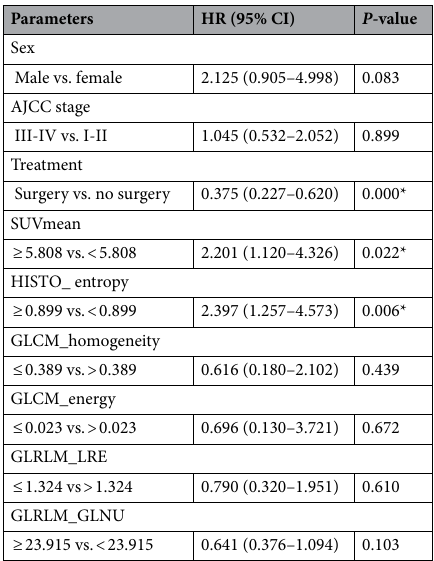
Table 6. Multivariate Cox regression analysis of OS. HR hazard ratio, CI confidence interval, AJCC American joint committee of cancer, SCC squamous cell carcinoma, SUV standardized uptake value, HISTO histogram, GLCM grey level co-occurrence matrix, GLRLM grey level run-length matrix, LRE long run emphasis, GLNU gray level non-uniformity for run. *Significant P -value (<